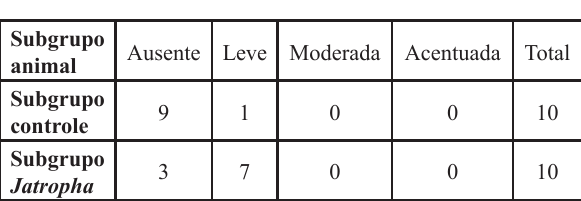
Avaliou-se a intensidade da fibrose determinada pela quantidade de fibras colágenas depositadas na zona de cicatrização (Figura 11). Após análise estatística dos dados, observou-se diferença estatisticamente significativa no 3º dia do pós-operatório (Figura 10). Este fato não ocorreu em relação aos dados do 7º dia do pós-operatório.